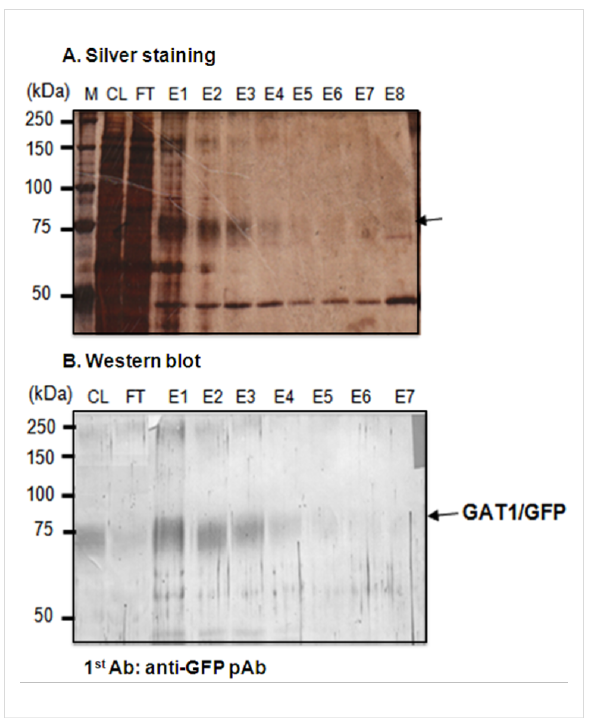
Figure 3: Isolation of the GAT1/GFP fusion protein from Sf 9 cells by mAb-GFP-conjugated affinity column chromatography with analysis of the eluted fractions from the mAb-GFP-conjugated affinity column with 4 M MgCl 2 (pH 6) by SDS-PAGE with silver staining and Western blot- ting. The arrow denotes the fragment of mAb-GFP. M: standard marker; CL: cell lysate; FT: flow-through; E1–E8: eluted fractions